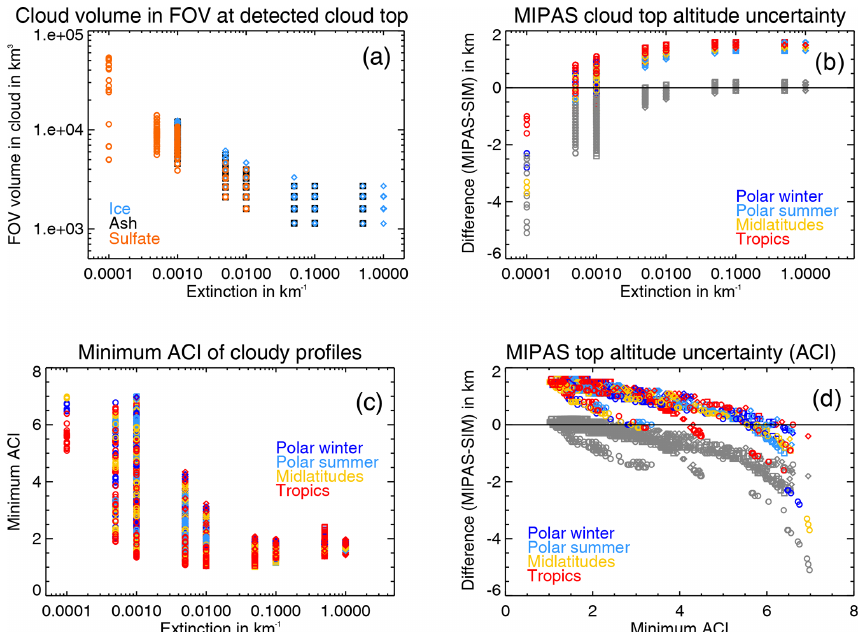
Figure 2. Characterisation of the cloud top height derived from simulations. (a) Volume of the field-of-view filled with cloud at the detected cloud top height as a function of extinction. The colours indicate the particle type: orange – sulfate aerosol, blue – ice, and black – volcanic ash. (b) Top height difference (detected–real top height) as a function of extinction. (c) Minimum ACI value within a cloudy profile as a function of extinction coefficient. (d) Top height difference as a function of minimum ACI value within a cloudy profile. In all panels the symbols indicate the particle type: circles – sulfate aerosol, diamonds – ice, and squares – volcanic ash. In panels (b) , (c) , and (d) the colours indicate the background atmosphere type: red – tropics, orange – midlatitudes, light blue – polar summer, and dark blue – polar winter. In panels (b) and (d) the coloured symbols show the top height uncertainties of all scenarios for the simulated 100m vertical sampling grid. For the MIPAS vertical sampling of 1.5km the coloured symbols indicate the upper limit and the grey symbols indicate the lower limit of the top height uncertainty range. Depending on the position of the cloud relative to the tangent altitude, the detected top height may fall anywhere in between. See the text and Table 2 for